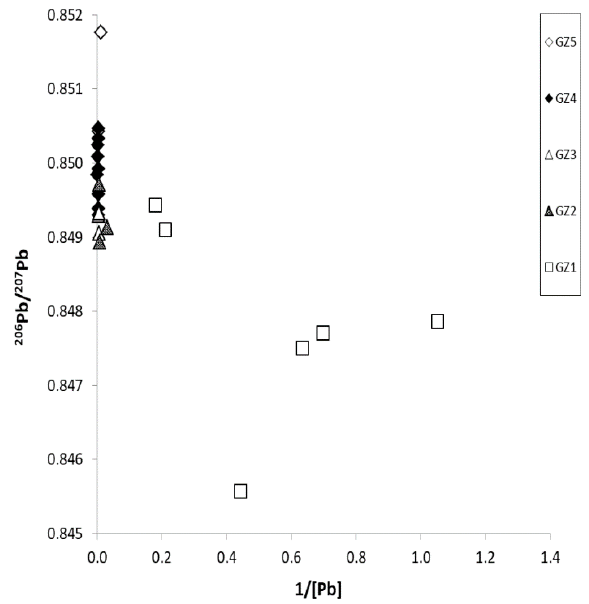
Figure 5. 1/Pb versus 206 Pb/ 207 Pb binary diagram, distinguishing the five geochemical zones in Core W3. Constructed by combining 206 Pb/ 207 Pb data from Table 2 with Pb content data (see Figure 2).